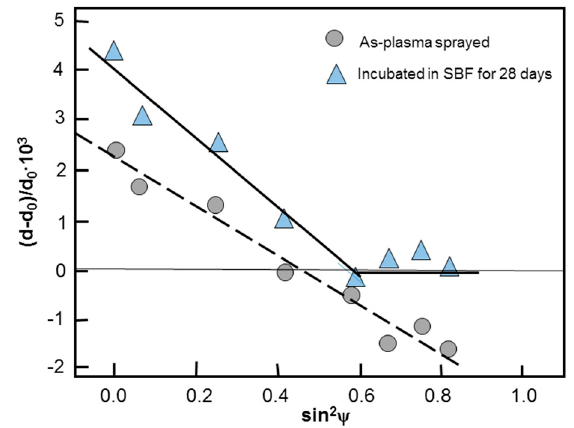
Figure 5. Development of near-surface residual stresses in as-sprayed HAp coatings (dotted line) and coatings incubated in simulated body fluid (SBF) for 28 days (solid line) [54].